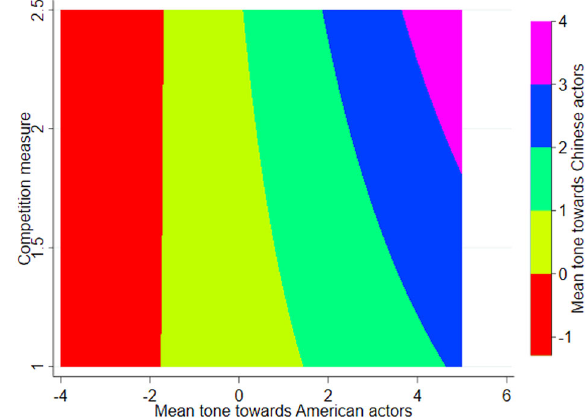
Fig. 4 Contour plot of predicted mean emotional tone taken by the local presses towards Chinese actors at the intersection of the Great Power Competition and distance from China.